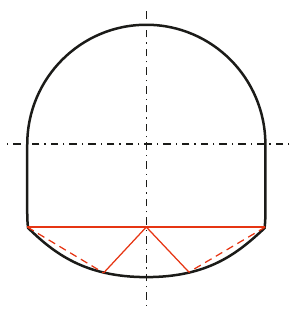
Figure 10: Similar triangle structures in the bottom arch.